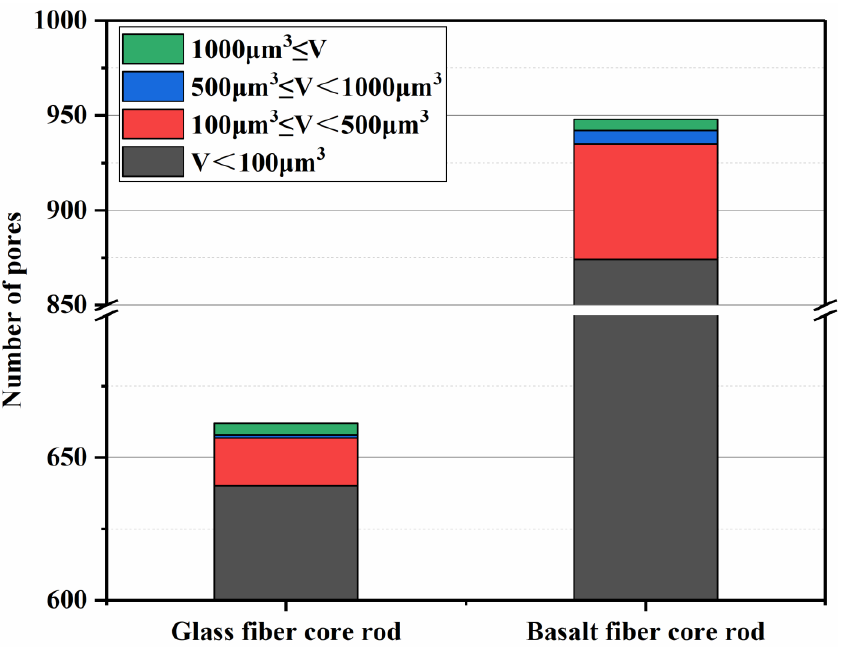
Figure 14. Three-dimensional pores of basalt fiber core rod ( a ) and glass fiber core rod ( b ).